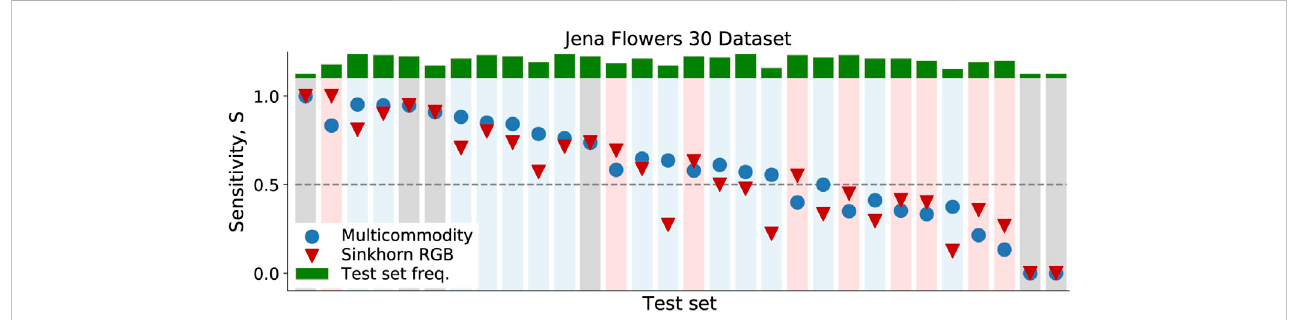
FIGURE 2 Sensitivity ontheJF30 dataset.Sensitivityvalues areshownforthemulticommoditydynamics(blue circles) andforSinkhorn RGB(redtriangles).Markers aresortedindescendingorderof S ,regardlessofthemethod.Backgroundcolorsareblue,red,andgray,when S ishigherforthemulticommoditymethod,the Sinkhorn algorithm, or none of them, respectively. In green, we plot frequency bars for all classes in the test set.